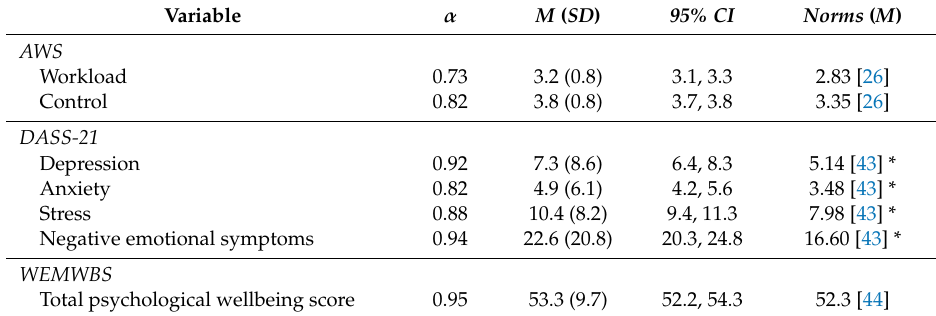
Table 2. Scale reliability (Cronbach’s alpha), descriptive statistics and comparative normative